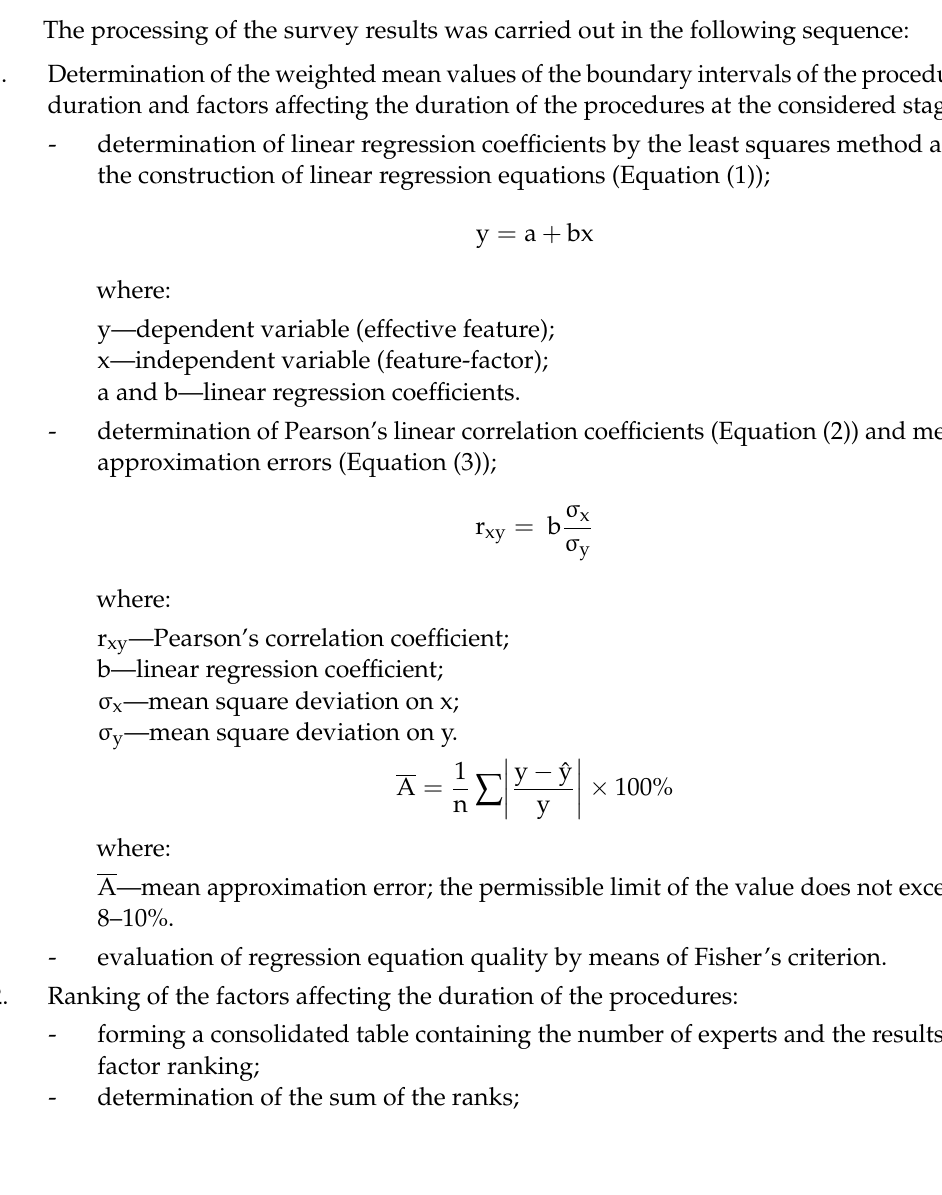
Figure 6. Processed results of Section 1 of the questionnaire. The question “The general construction experience of experts”.